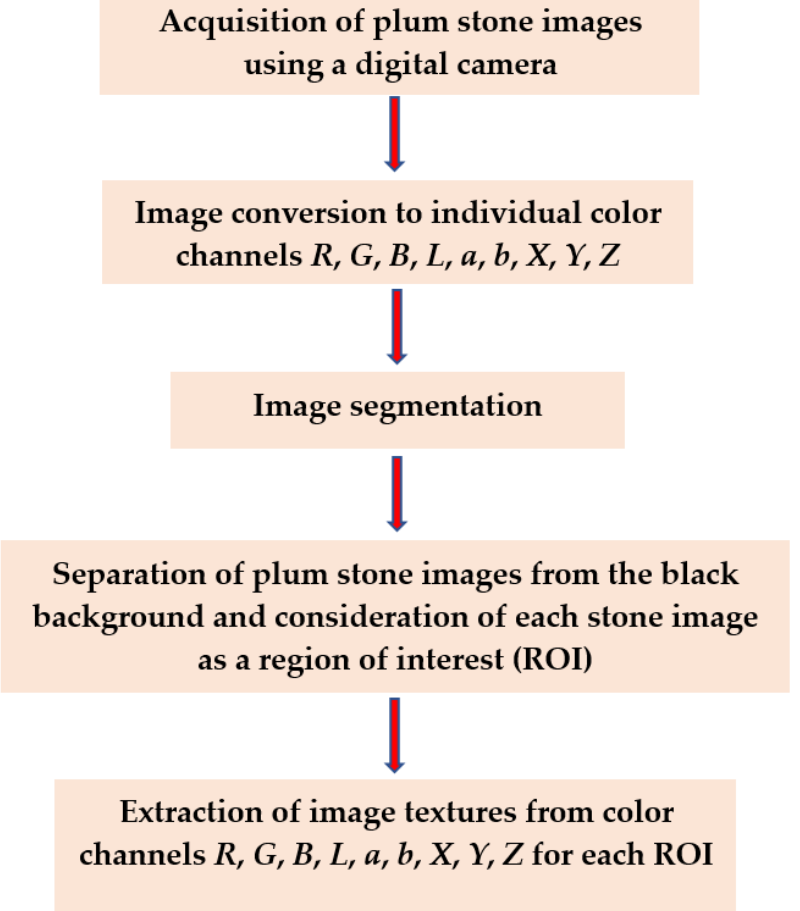
Figure 1. The scheme procedure for the processing of acquired plum stone images using the MaZda software.